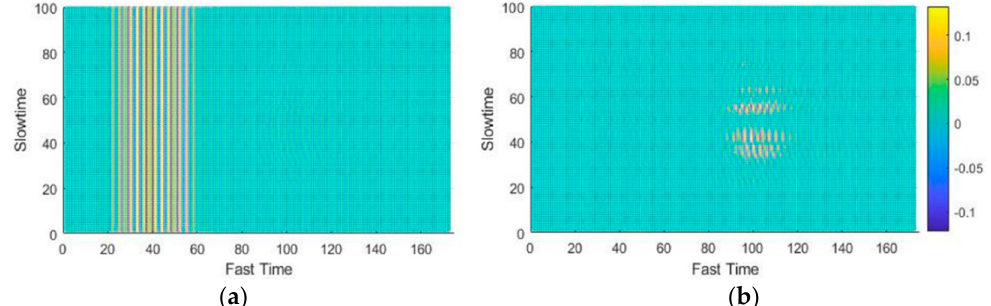
Figure 11. Clutter removal: ( a ) signal before removal and ( b ) signal after removal.